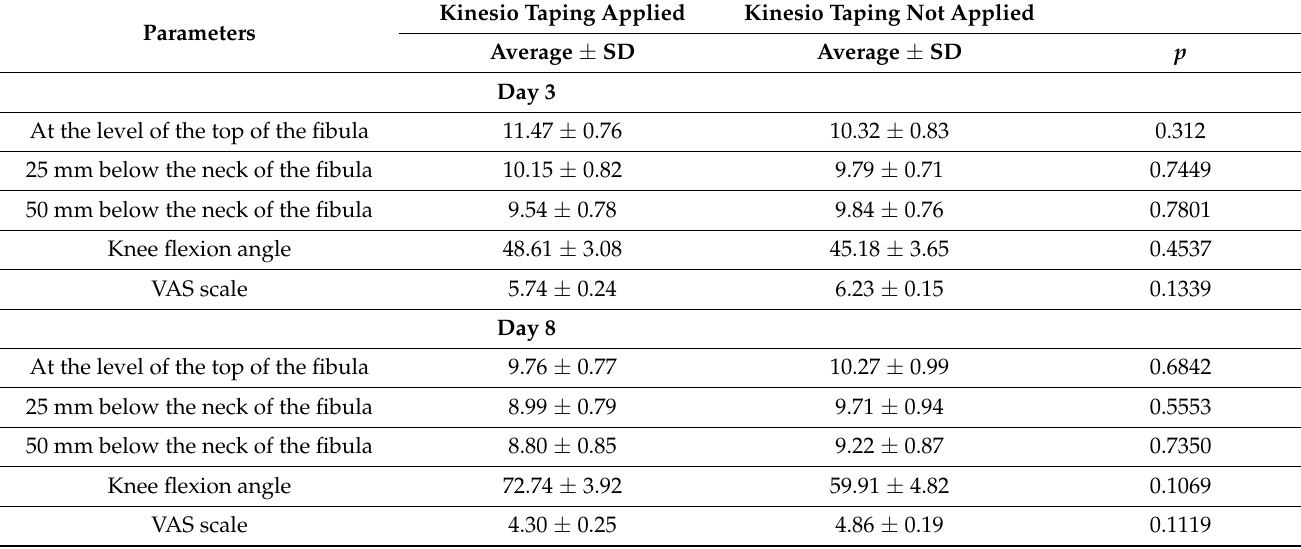
Table 4. Comparisons of the studied